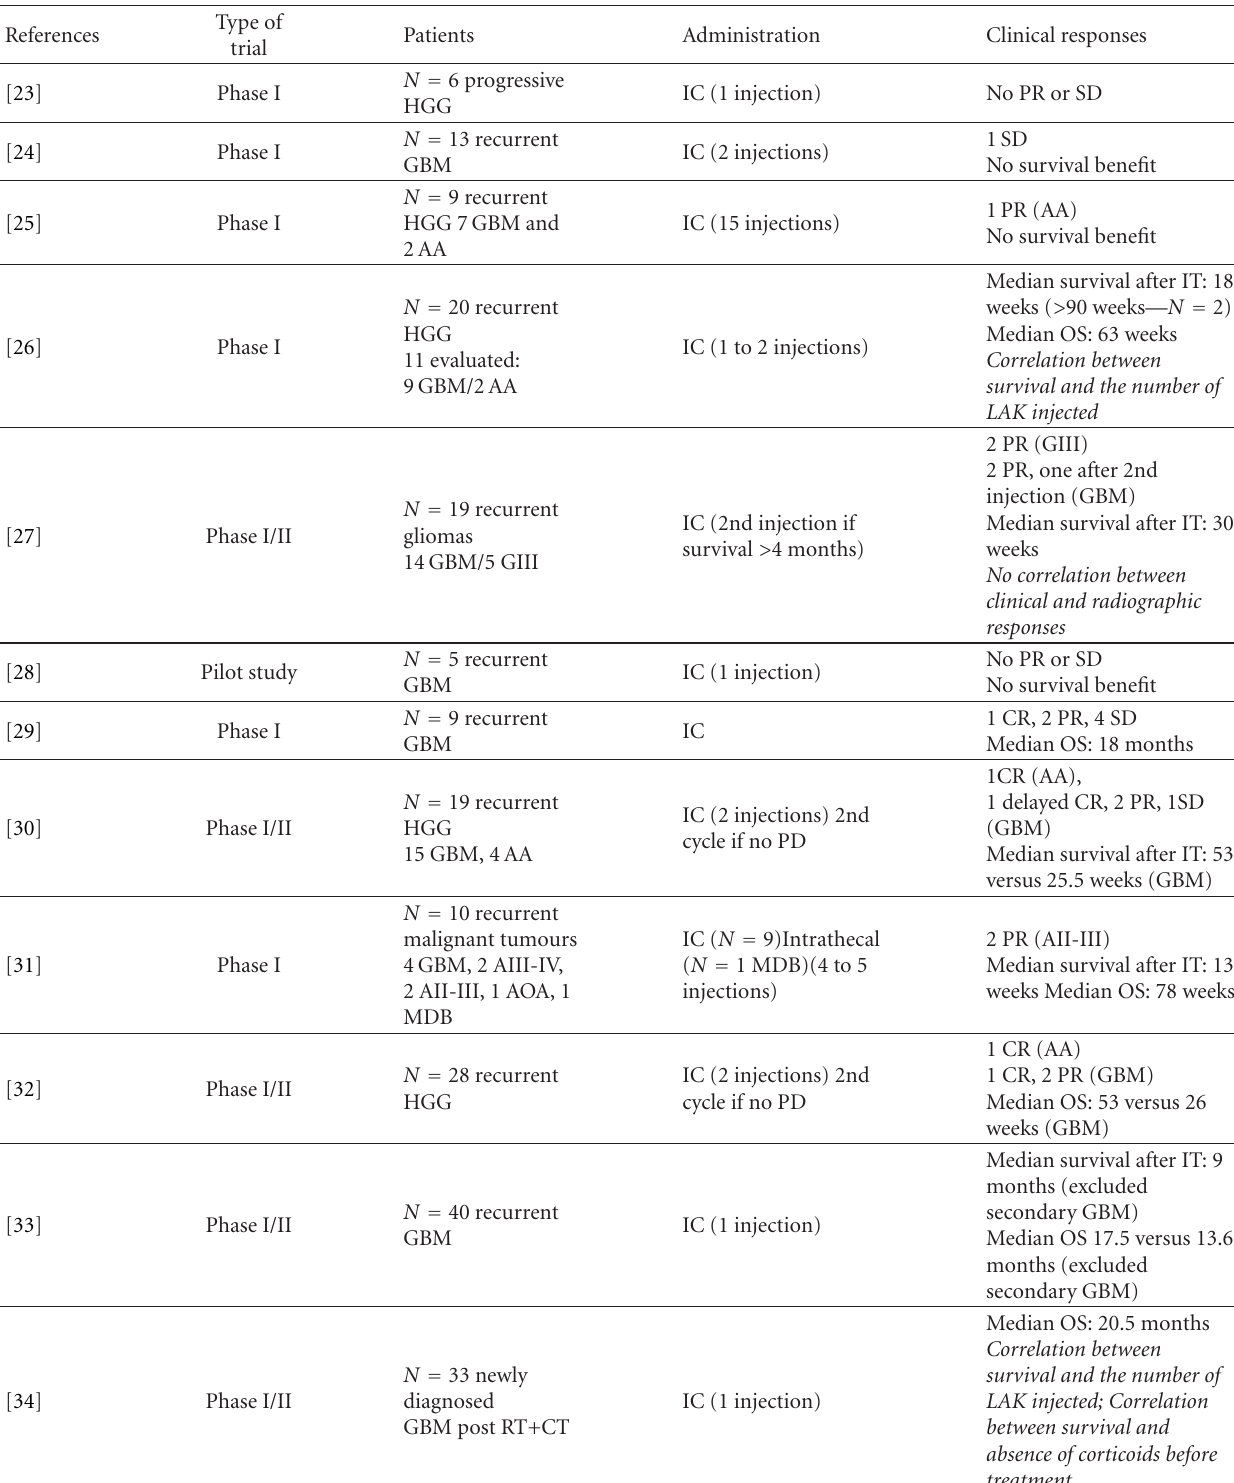
∗ : Abbreviations used in this table: AII/III: grade II and III astrocytoma; AIII/IV: grade III and IV astrocytoma; AA: anaplastic astrocytoma; AO: anaplastic oligodendroglioma; AOA: anaplastic oligoastrocytoma; CR: complete response; CT: chemotherapy; GII/III: grade II and III glioma; GIII/IV: grade III